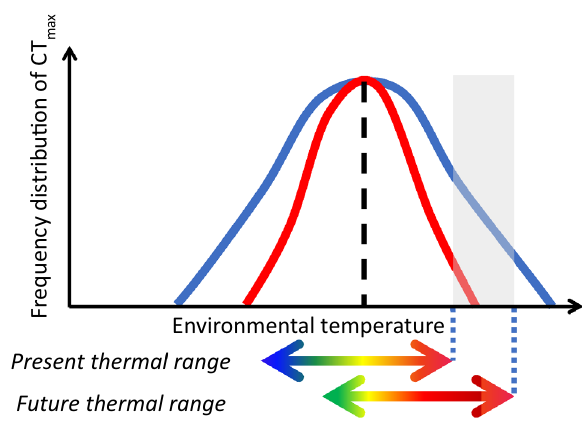
Figure 1. Theoretical representation of different frequency distribution curves of CT max . The curves of two species have the same mean CT max (dashed line) but different standard deviations (S.D.). With ongoing climate change, represented by the shift in the thermal range (double-pointed arrows), individuals of the species with the narrower S.D.CT max (red curve) are less likely to survive compared to individuals of the species with the wider S.D.